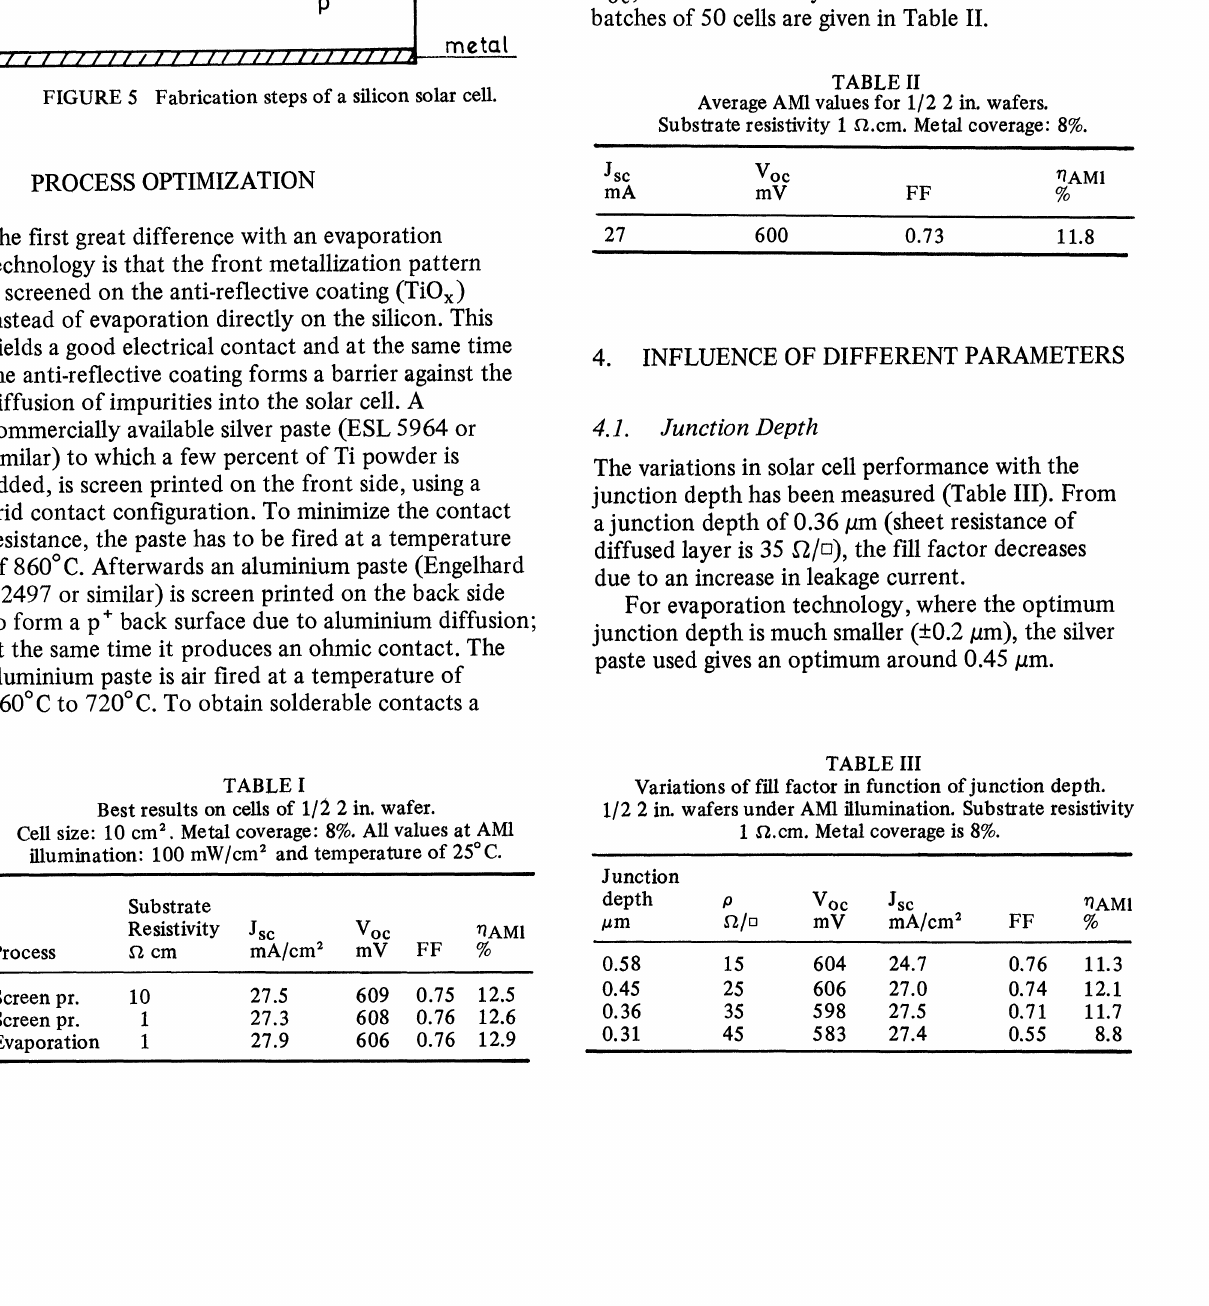
FIGURE 5 Fabrication steps of a silicon solar cell.